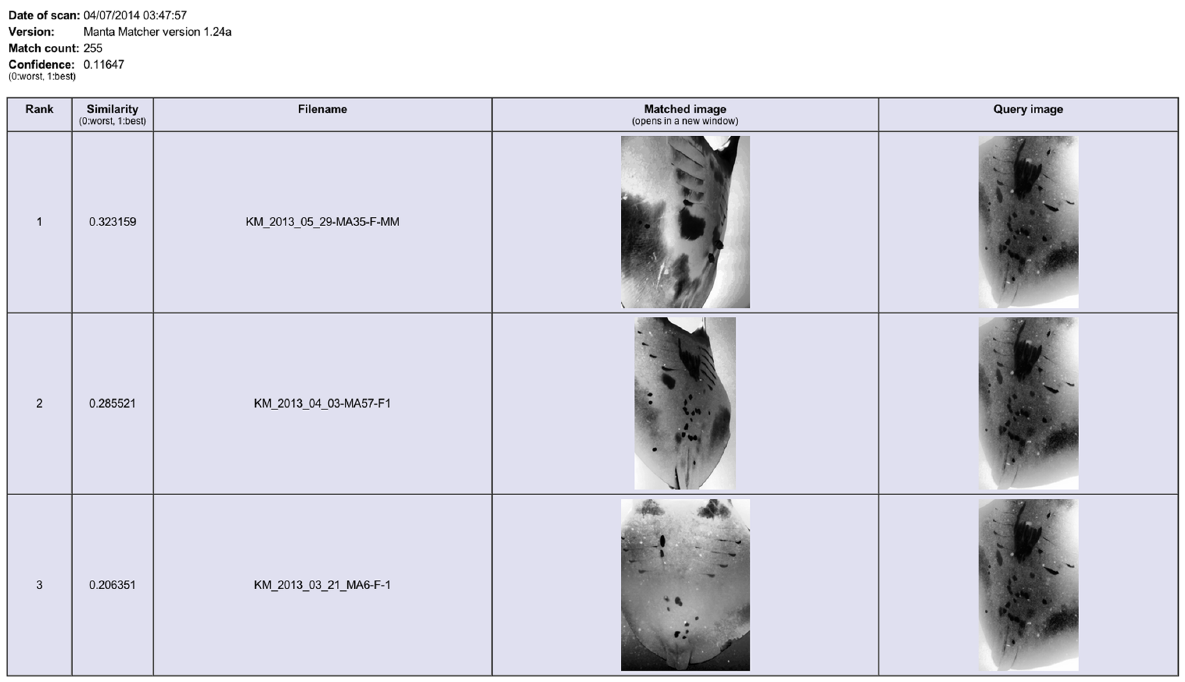
Figure 5. The ‘Manta Matcher’ matching algorithm screen grabs for INNLP0031A showing the top three matched images. Ranked hit 2 (re-sighting in WM & K) is a true match for the query image of ray INNLP0031A (initial sighting in NP).